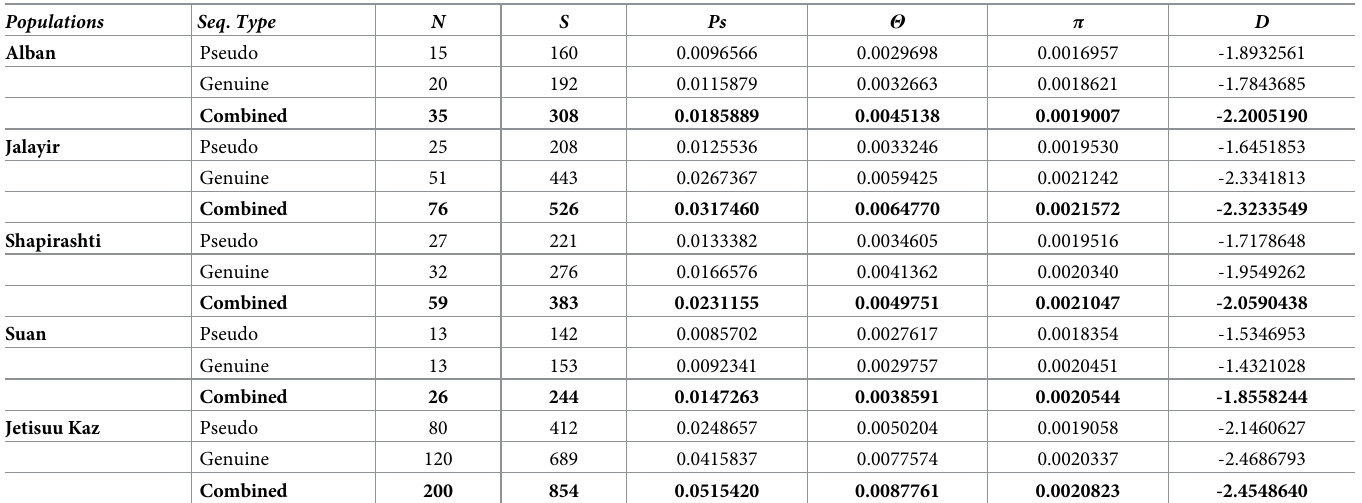
Table 2. Results from Tajima’s Neutrality Test